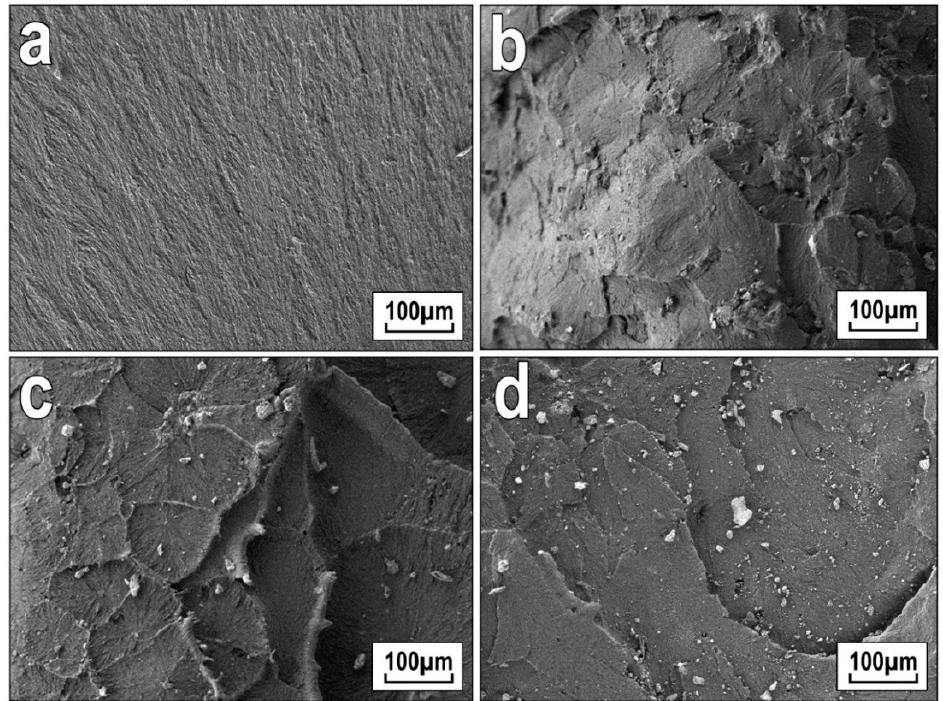
Figure 6. Microphotographs of the structure of ( a ) the initial ultra-high-molecular weight polyethylene (UHMWPE) and polymer composite materials (PCMs) based on UHMWPE with an addition of synthetic wollastonite ( b ) 0.5 wt.%, ( c ) 1.0 wt.%, and ( d ) 2.0 wt.%.